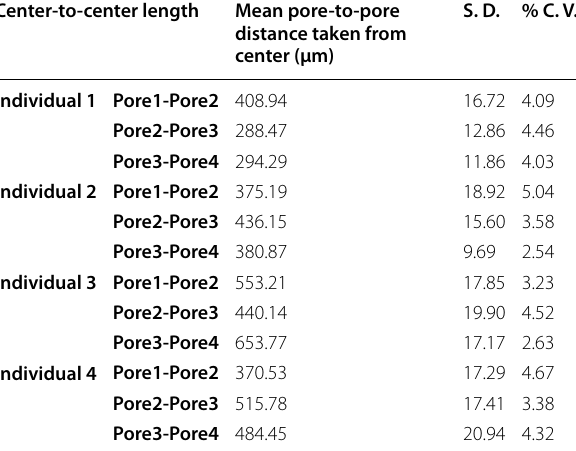
Table 9 Mean angle between center-to-center lengths,